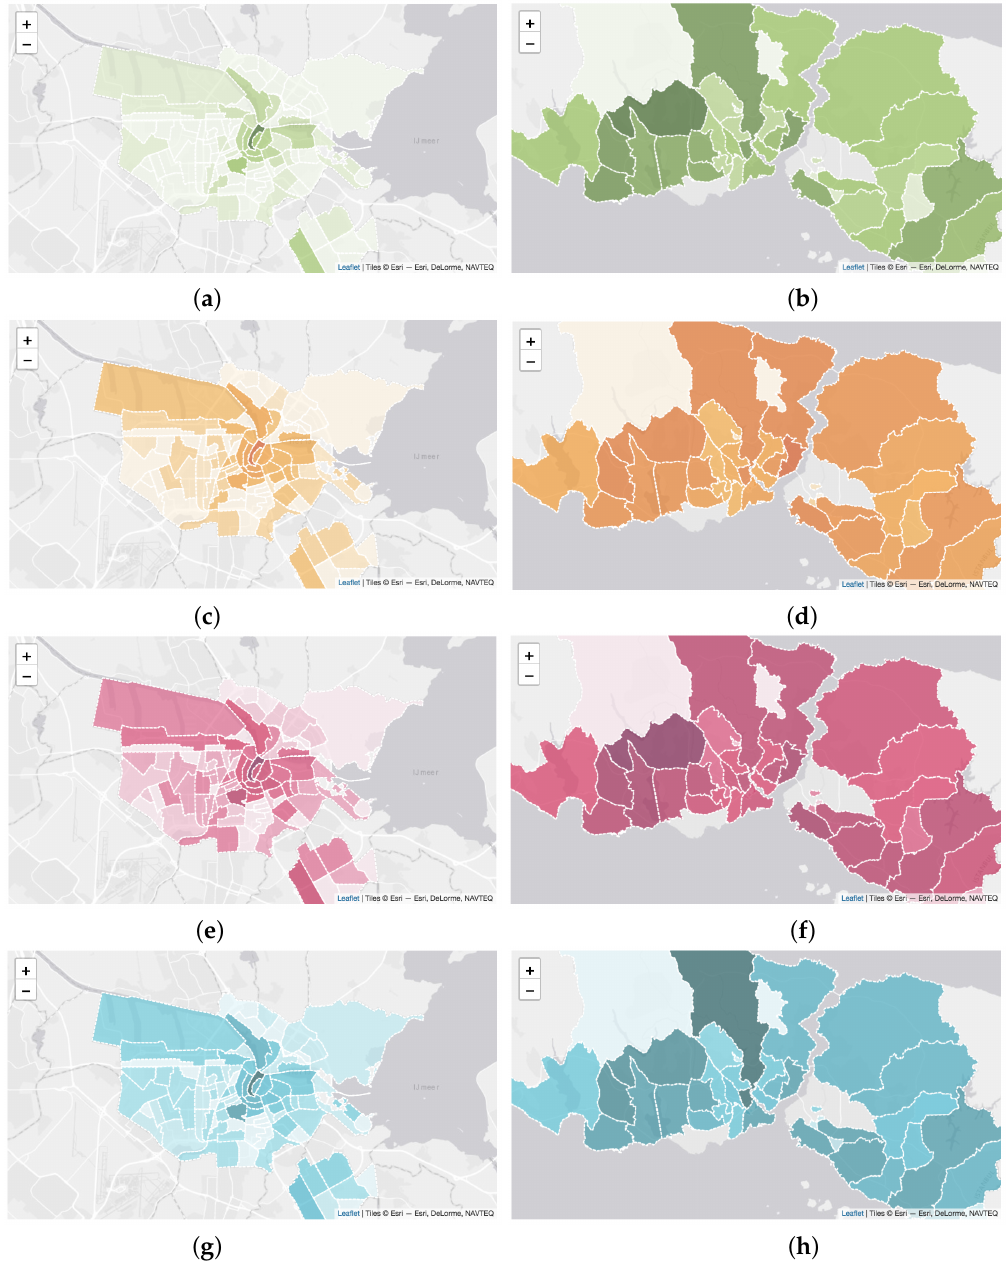
Figure 9. Map visualizing the distribution of social media posts; ( a , b ) refer to dwelling, ( c , d ) refer to food consumption, ( e , f ) refer to leisure and ( g , h ) refer to